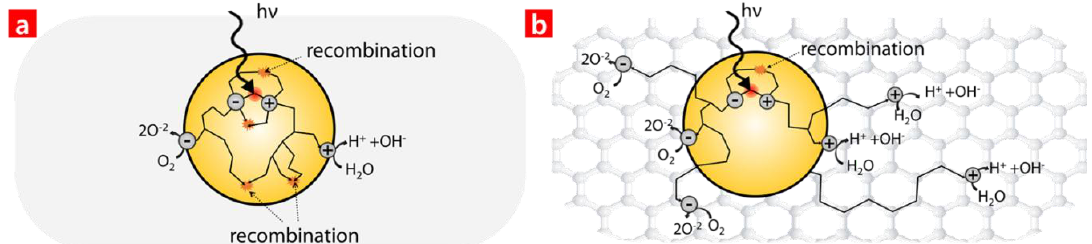
Figure 3. The absorbance spectra of the methylene blue (MB) solution where ( a ) GaO; ( b ) an HC of GaO and 4% GO; and ( c ) an HC of GaO and 10% GO were added to the MB. Each sample was exposed to 254 nm of radiation at different times.